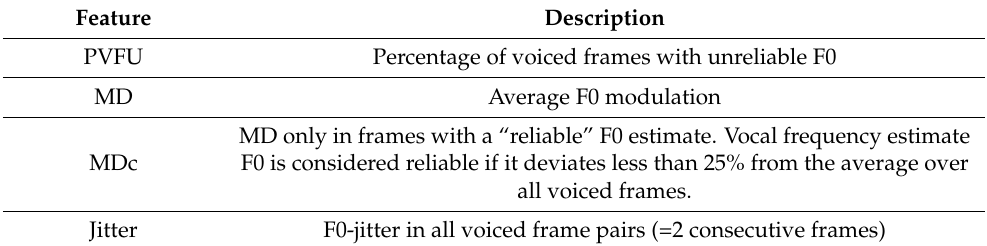
Table 2. Cont . Feature Description PVFU Percentage of voiced frames with unreliable F0 MD Average F0 modulation